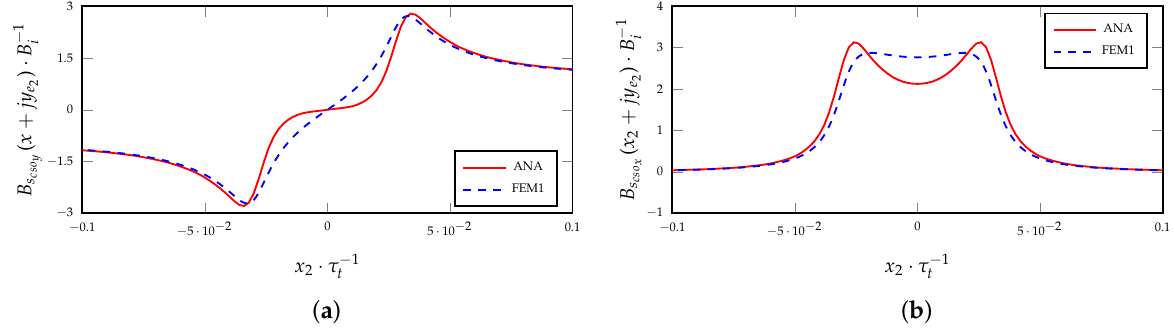
in comparison 2